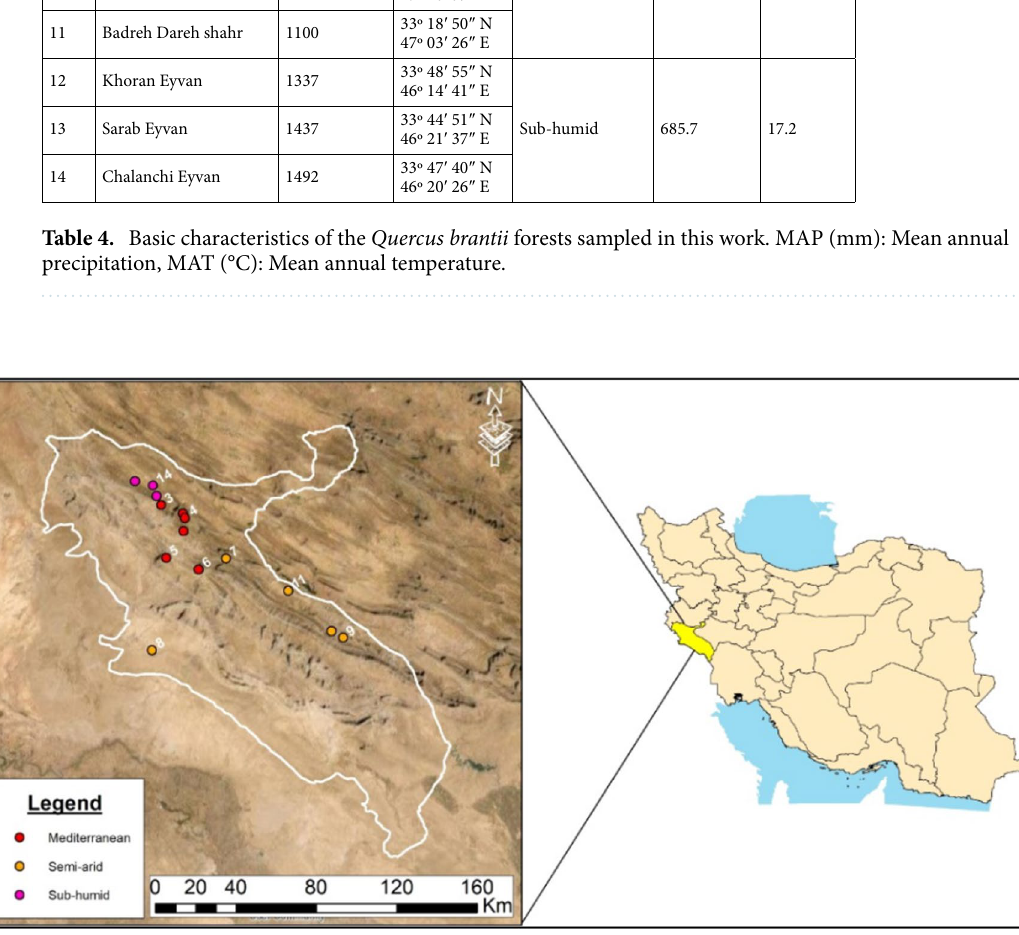
Anatomical traits. In order to measure leaf anatomical traits, due to high density of trichomes and to better visualize of the epidermal layer, the density of trichomes was reduced using a twin-blade razor and adhesive tape. Chlorophylls were extracted by immersion in a mixture (1.5:100 v/v) pf acetic acid (99%) and hydrogen peroxide (30%), respectively at 100 °C for one hour in a Bain-Marie water bath 64 . After twice washing in distilled water,